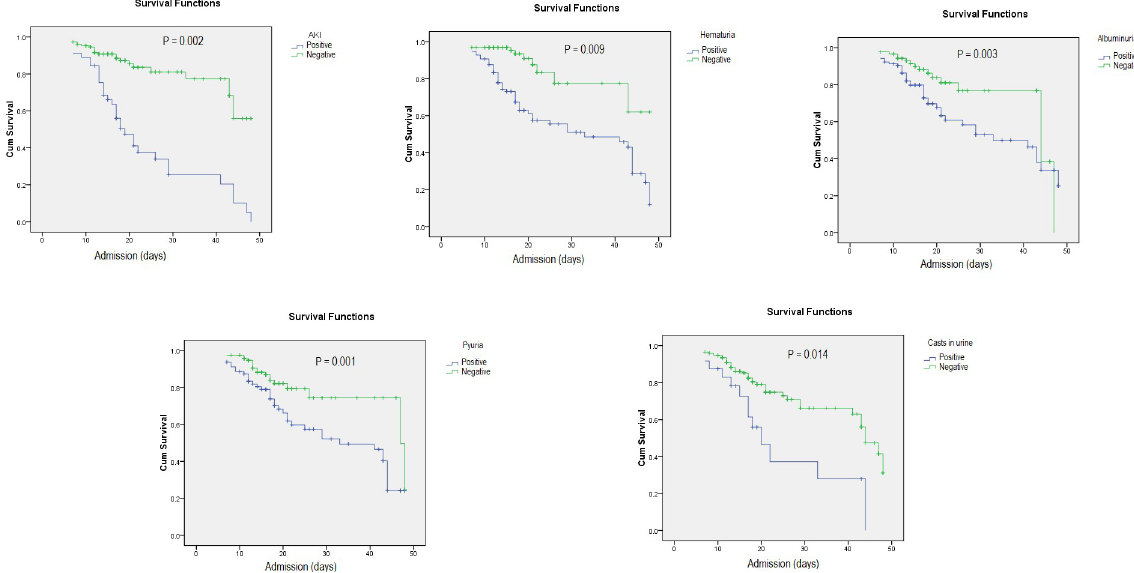
Fig 1. Renal involvement is associated with an increased risk of death among hospitalized patients with COVID-19. A Kaplan–Meier analysis of the effect of different manifestations of renal involvement on case fatality in hospitalized patients with COVID-19 showed that renal involvement is associated with an increased risk of death ( P -value < 0.05 for all